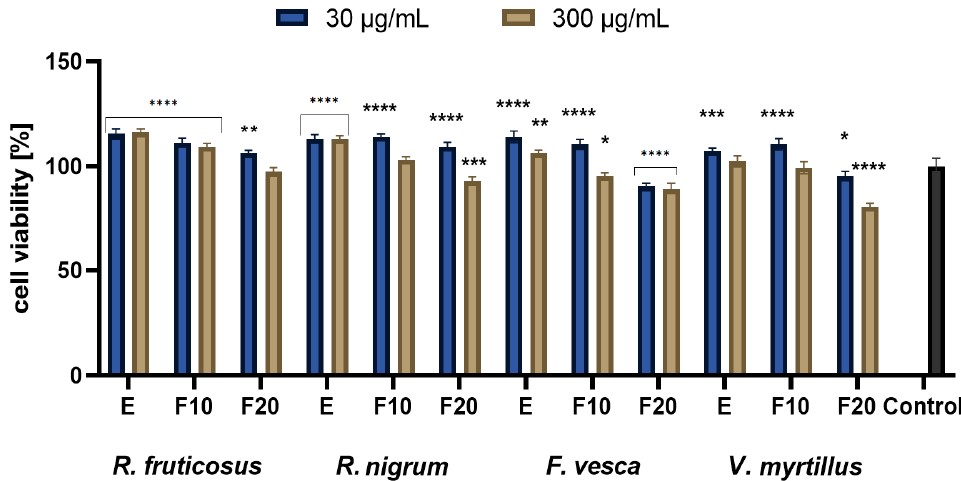
Figure 4. The reduction in resazurin after 24 h exposure to R. fruticosus L., R. nigrum L., F. vesca L., V. myrtillus L. extract and kombucha ferments (at concentrations of 30 and 300 µ g/mL) in cultured fibroblasts (BJ). Data are the mean ± SD of three independent experiments, each of which consists of three replicates per treatment group., **** p < 0.0001, *** p < 0.0003, ** p < 0.0015, * p < 0.0035 versus the control (100%).